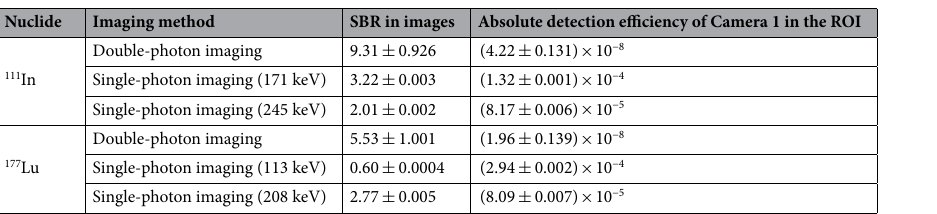
Table 1. SBR in images and absolute detection efficiency of Camera 1 for 2D imaging. The standard errors are also shown.